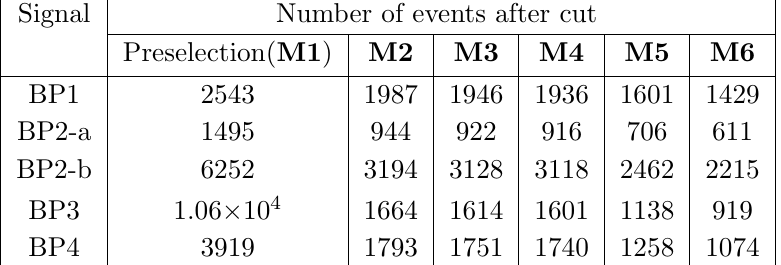
Table 6 . Mono-lepton + missing energy signal (cid:12)nal state number of events at 100 fb (cid:0) 1 for SUSY signals. Note that the events have been rounded-o(cid:11) to the nearest integer. Cross-sections have been scaled using NLO K-factors obtained from Prospino